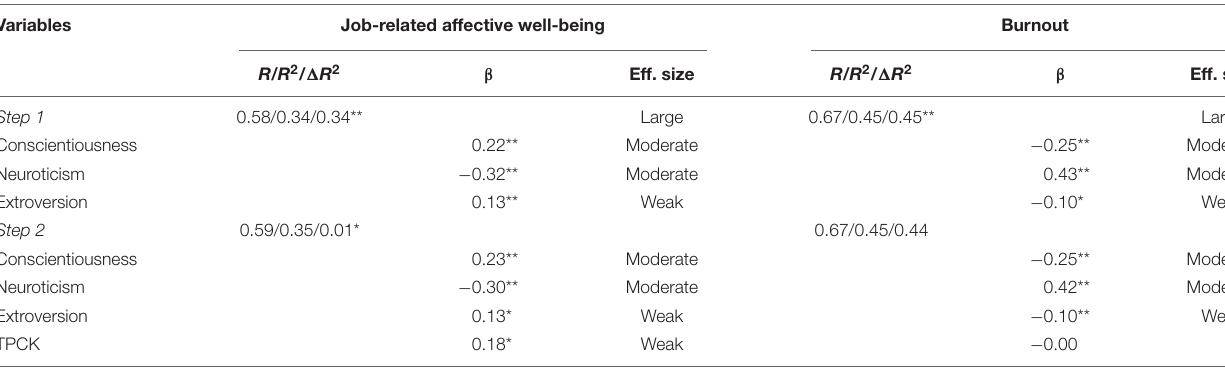
TABLE 3 | Hierarchical multiple regression analyses ( N =